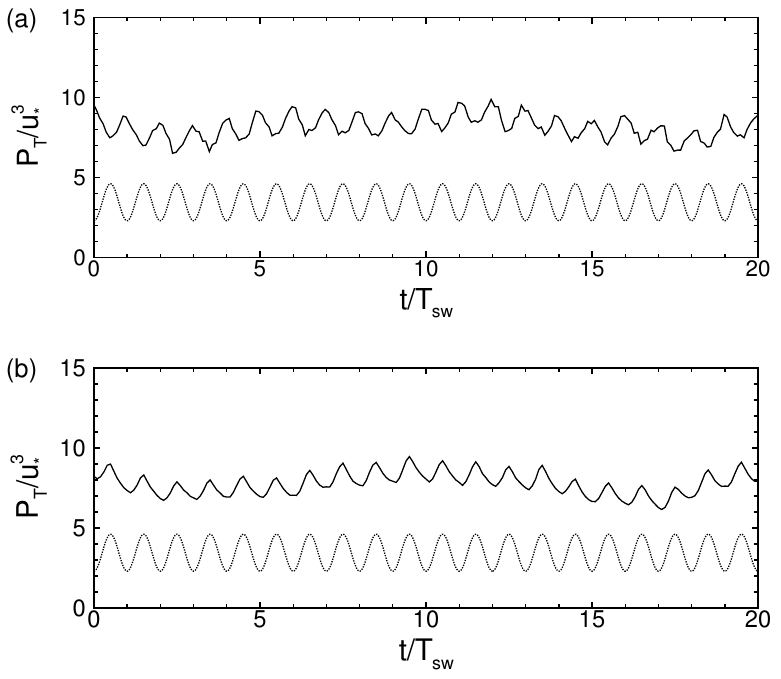
Figure 9. Time series of averaged extracted power density P T of an offshore wind farm for a ( a ) fixed turbine and ( b ) floating turbine in swell-wave condition. Power density is normalized by wind-friction velocity u ∗ , and time t is normalized by swell-wave period T sw . The solid line is for P T and dashed line indicates the swell phase. For illustration purposes, the amplitude of the swell was not plotted to